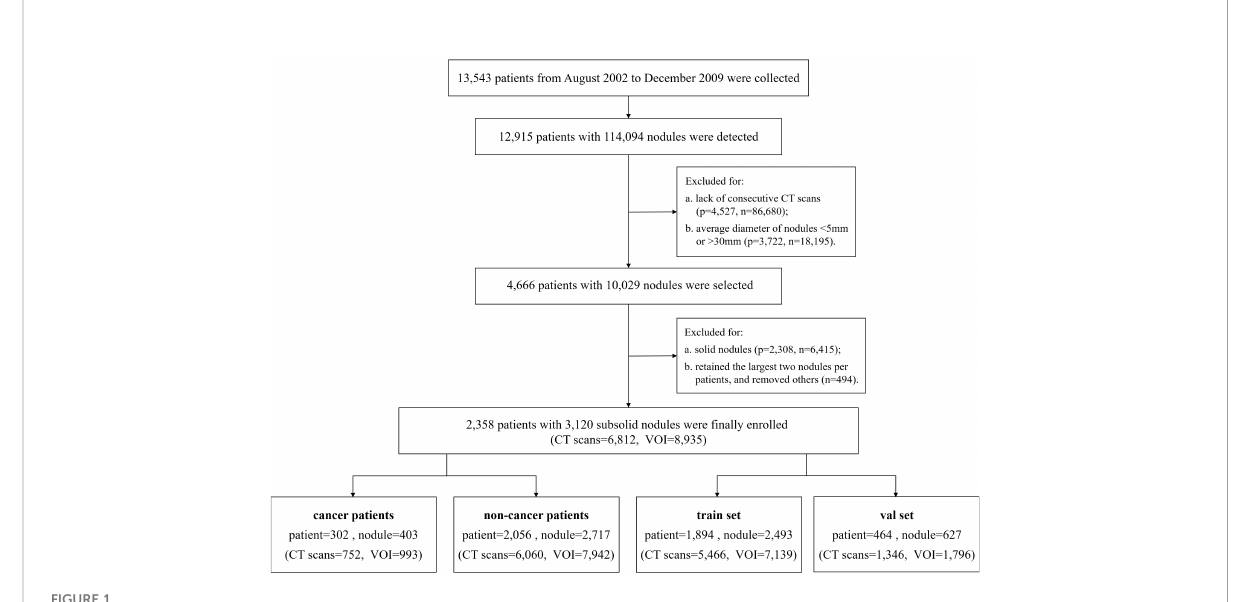
FIGURE 1 Flowchart of case selection on the NLST data